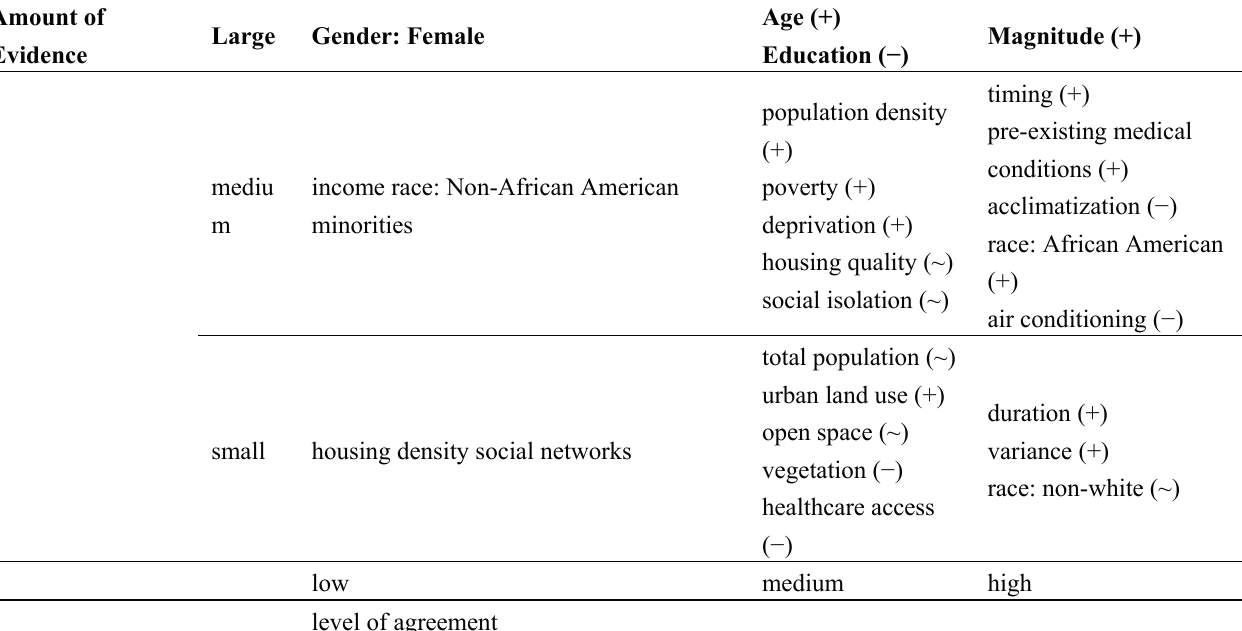
Table 2. Determinants of heat vulnerability, levels of evidence and agreement